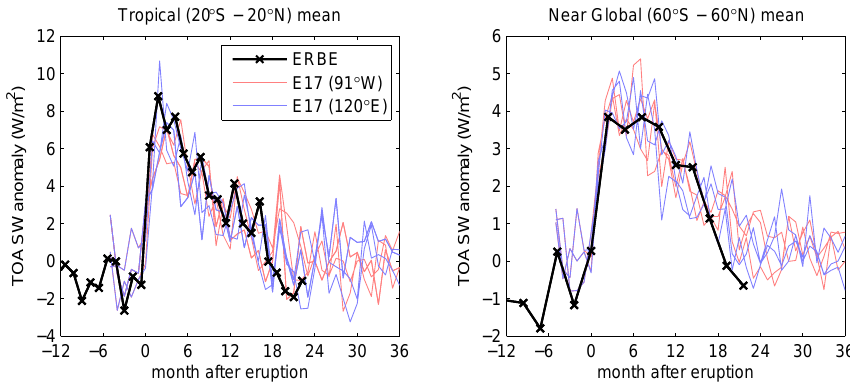
Fig. 2. Tropical (20 ◦ S–20 ◦ N) and near-global (60 ◦ S–60 ◦ N) reflected shortwave flux anomalies at the top of the atmosphere from Pinatubo eruption period ERBE observations (black) and MAECHAM5-HAM Pinatubo-magnitude eruption simulations with eruptions at 15 ◦ N, 91 ◦ W (red) and 15 ◦ N, 120 ◦ E (blue). Model anomalies calculated with respect to a 20-yr control simulation, ERBE anomalies calculated with respect to the 1985–1989